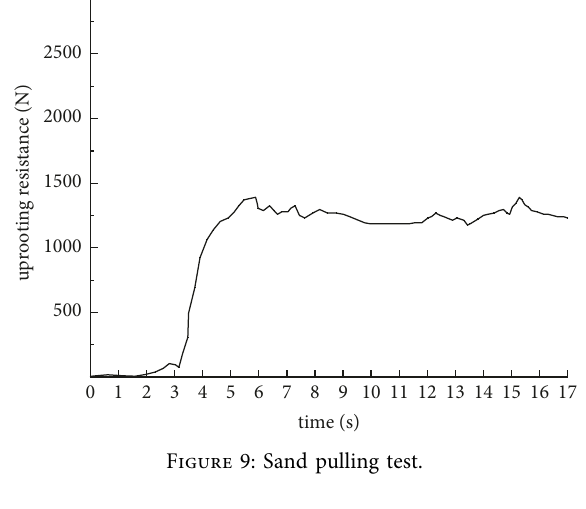
Figure 9: Sand pulling